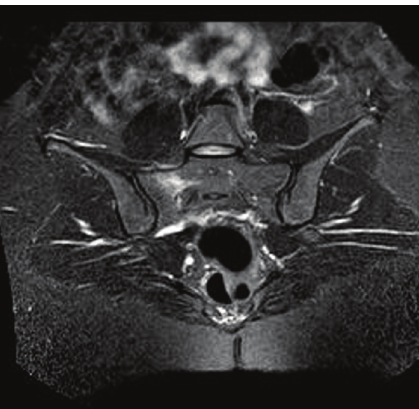
Figure 3: CT scan: axial view that showed the fracture line from the anterior border of sacrum to the right sacroiliac joint.